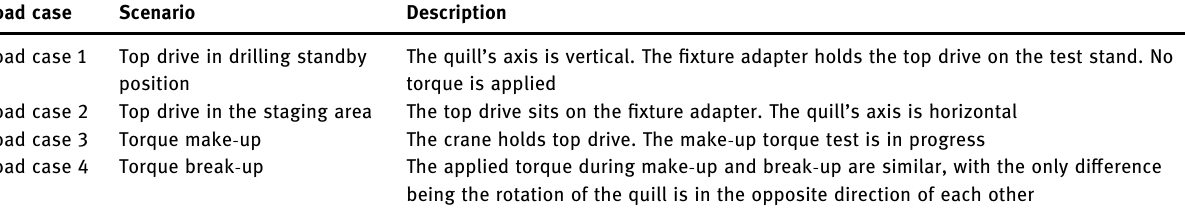
Table 2: Load cases and scenarios Load case